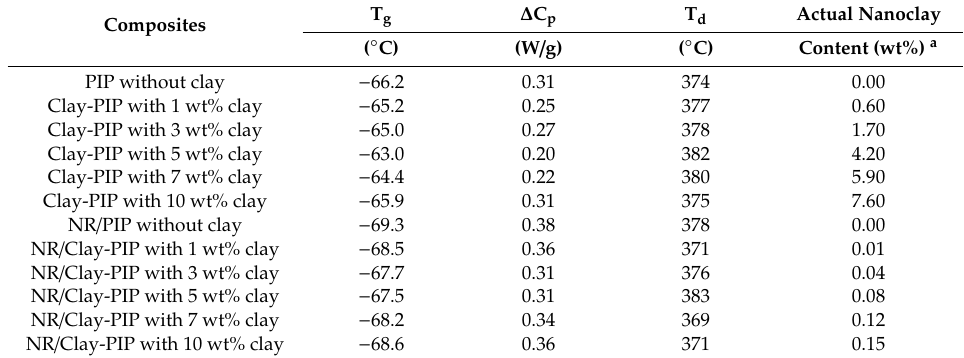
Table 5. Thermal properties of Clay-PIP and NR / Clay-PIP composites with di ff erent amounts of nanoclay. The Clay-PIP were prepared using starve-fed (SFE) emulsion polymerization